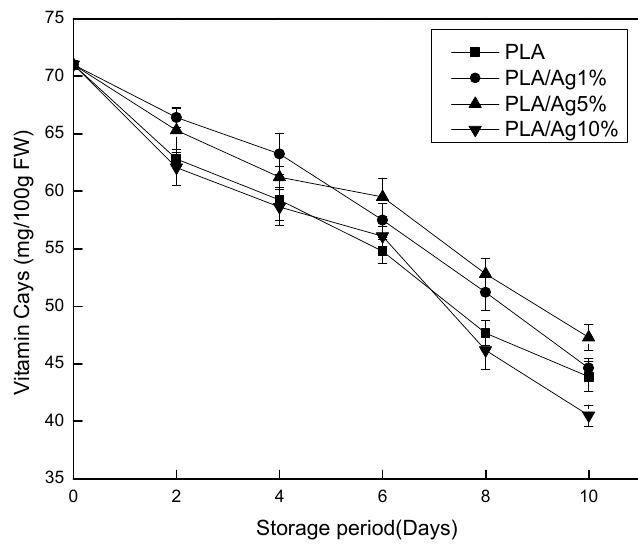
Figure 6. Effect of different concentration of nano-Ag active packages on the vitamin C level strawberry stored at 4 ± 1 °C for 10 days. Data are presented as mean ± standard deviation.